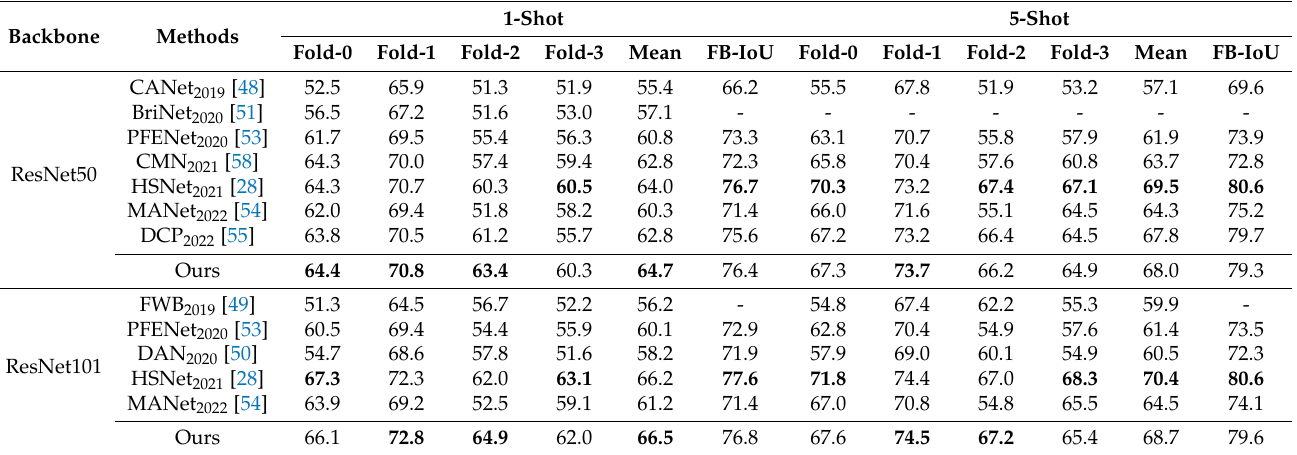
Table 1. Results and comparison of mIoU and FB-IoU on the four folds of PASCAL-5 i . Bold numbers represent the best